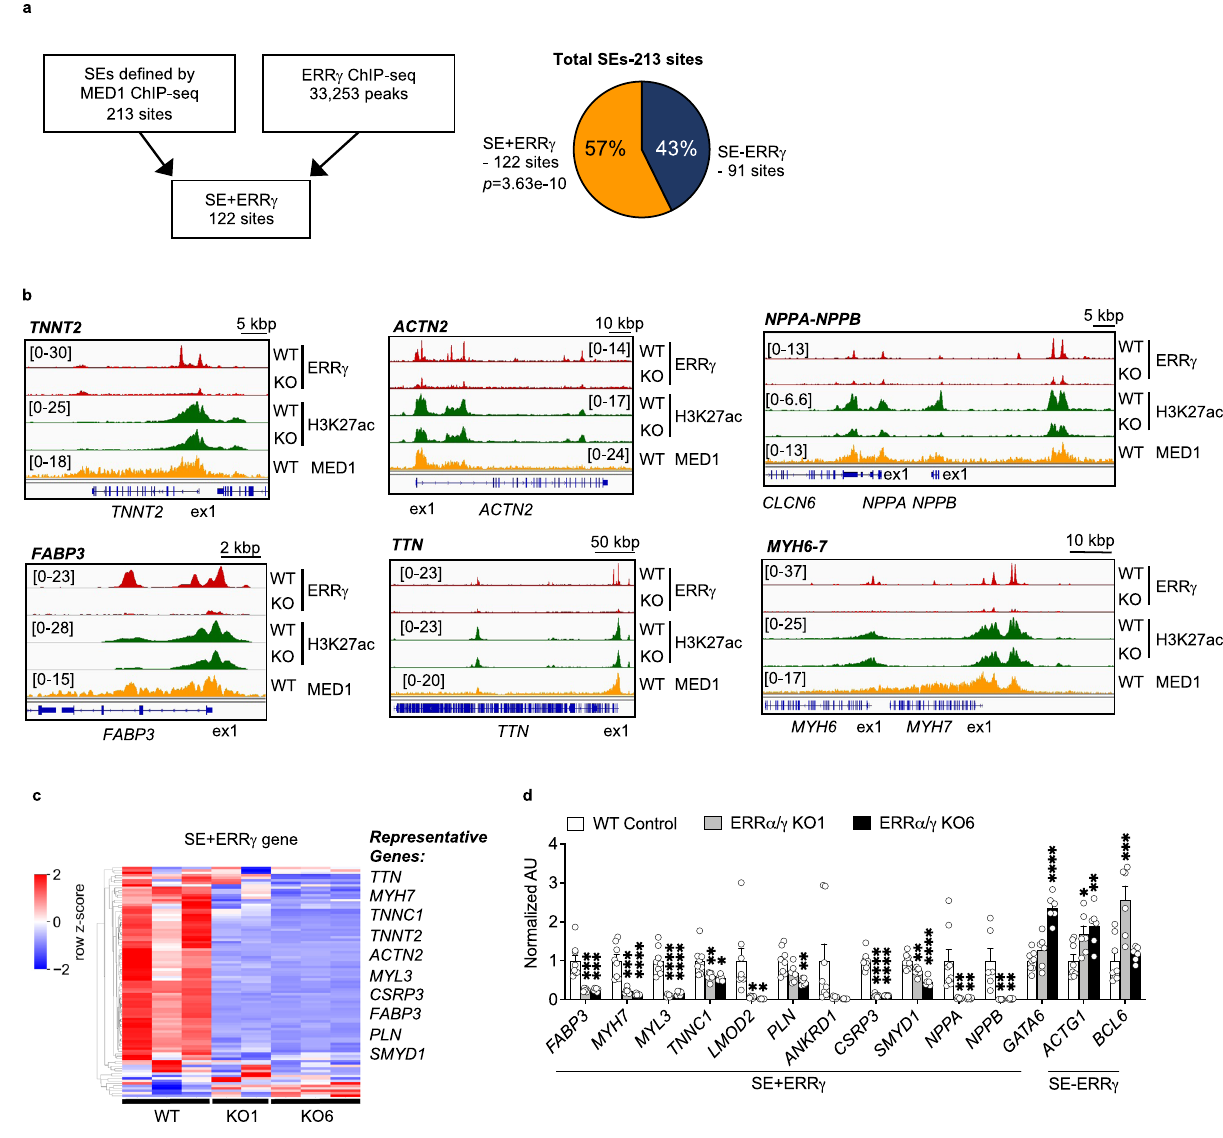
Fig. 3 ERR γ occupies super-enhancer regions linked to cardiac-enriched structural and metabolic genes in hiPSC-CMs. a Schematic indicates the intersection analysis with published MED1 chromatin immunoprecipitation sequencing (ChIP-seq; GSE85631) and ERR γ ChIP-seq (GSE113784). Pie chart shows the percent of signi fi cantly overlapped sites (Fisher ’ s exact test) from ERR γ ChIP-seq peaks and super-enhancers (SEs) de fi ned by the published MED1 ChIP-seq (GSE85631). b Genome browser track of ERR γ (GSE113784), H3K27ac (GSE165965), and MED1 ChIP-seq (GSE85631) signals at indicated loci. c Heatmap represents the z-score of expression changes of SE + ERR γ genes in ERR α / γ knockout (KO) human induced pluripotent stem cell-derived cardiomyocytes (hiPSC-CMs). Representative genes that are signi fi cantly downregulated in both KO lines are listed next to the heatmap. The row-wise z-scores of fragments per kilobase of exon per million reads mapped (FPKM) values of the presented genes are provided in Supplementary Table 1. d Bar graphs represent mRNA expression levels of genes associated with SE + ERR γ or SE determined by real-time quantitative polymerase chain reaction (RT- qPCR) in wild-type (WT)-Control ( n = 8 or n = 6 for NPPB ) and two different lines of ERR α / γ KO hiPSC-CMs (KO1 and KO6, n = 6). * p < 0.05, ** p < 0.01, *** p < 0.001, **** p < 0.0001, one-way ANOVA followed by Dunnett ’ s multiple comparison test. All bars represent the means ± SEM. n denotes independent biological